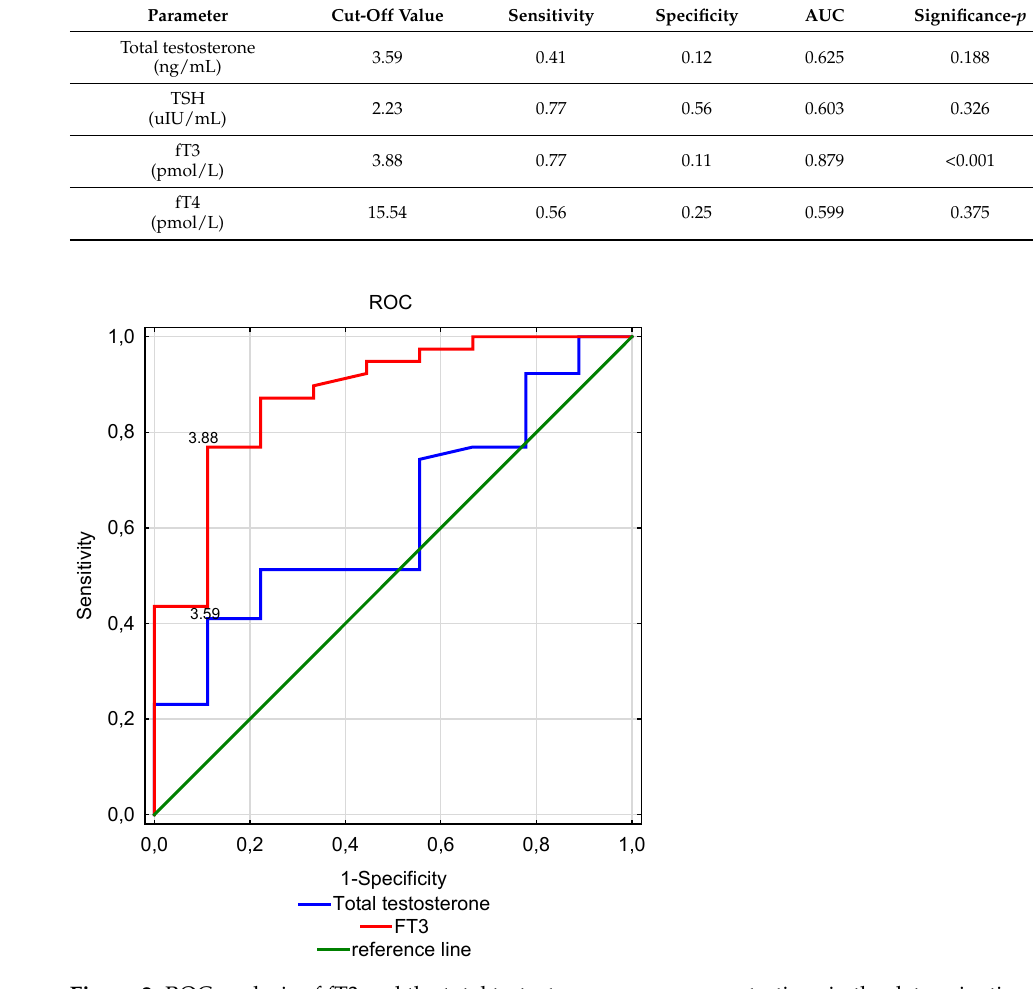
Figure 2. ROC analysis of fT3 and the total testosterone serum concentrations in the determination of prognosis in male dialysis patients.